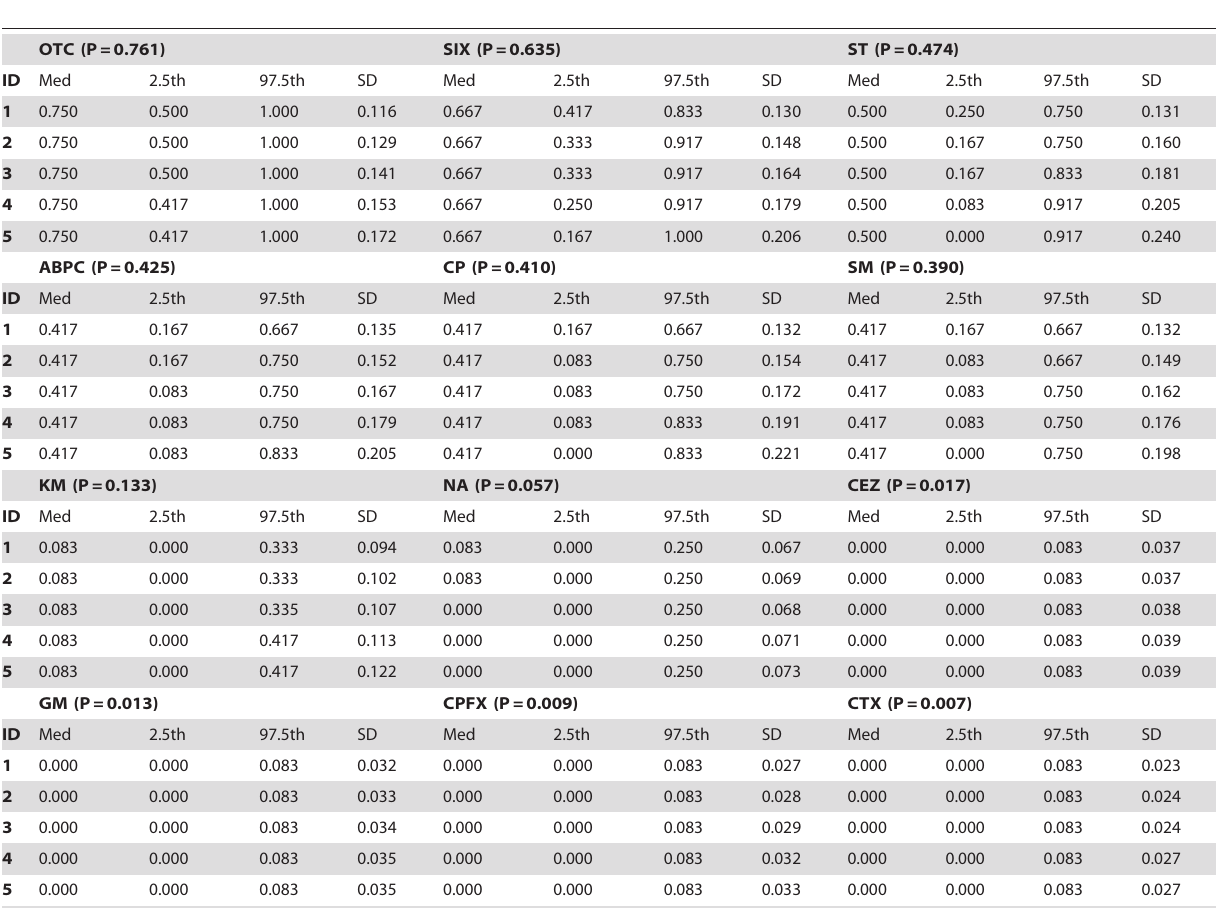
Table 2. Proportions of E. coli isolates resistant to 12 different antimicrobials obtained with 6 different sampling strategies and 10,000 bootstrap replications per